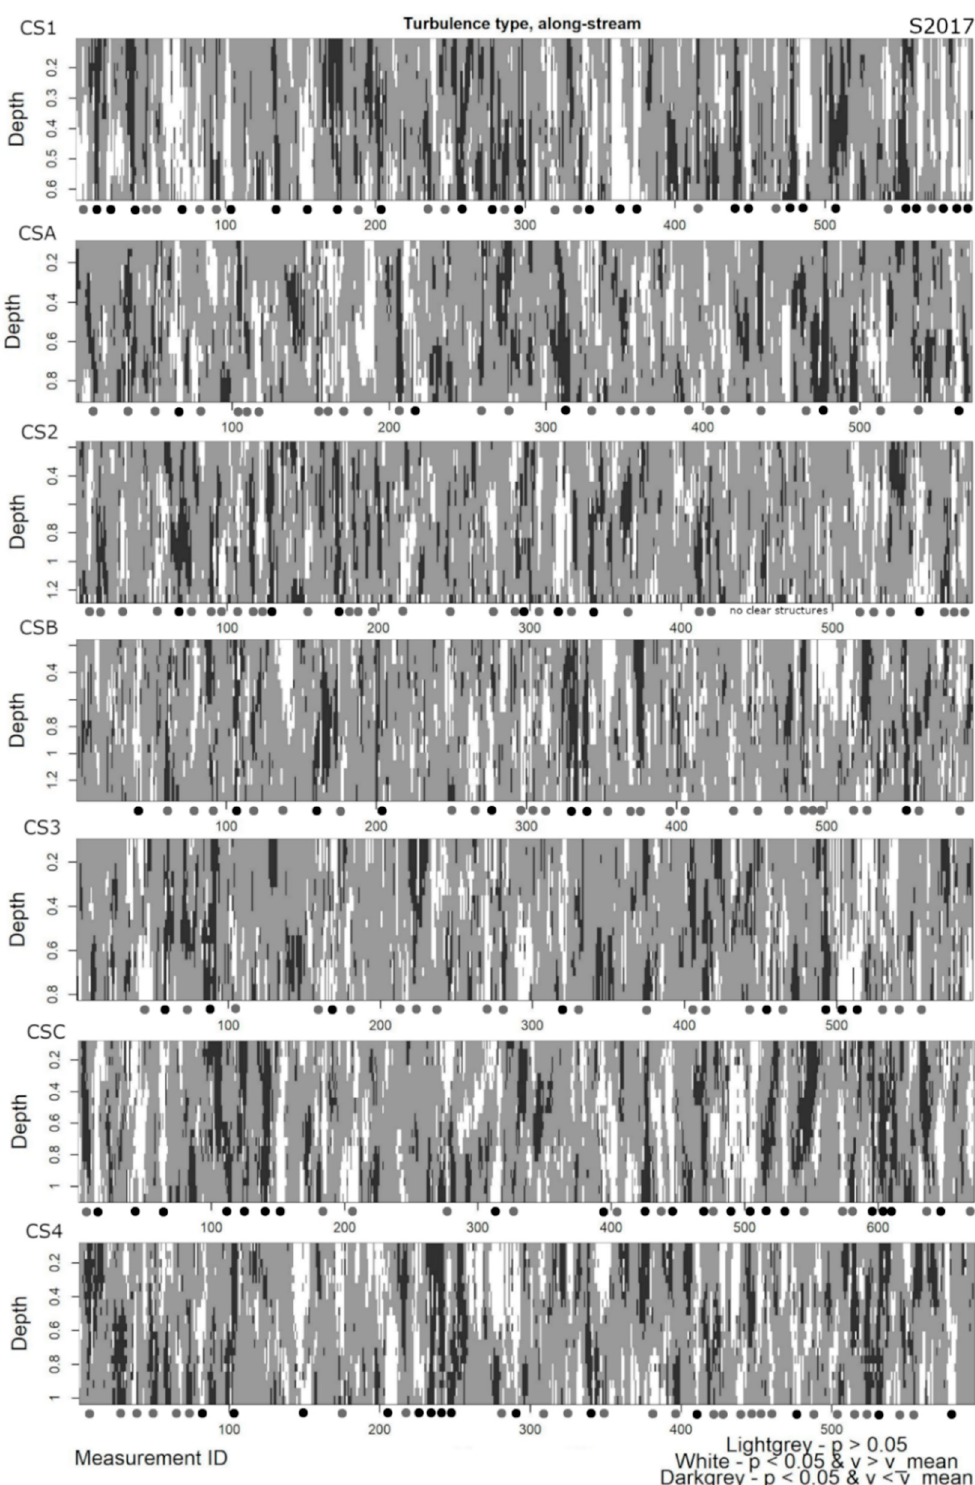
Figure 4. The LISA analysis results at each measurement location, calculated based on along-stream (i.e., streamwise) velocity of S2017. Measurement ID means the sample numbers ( n ), and therefore also represents seconds. The black dots indicate the occurrence times of statistically significant strong high and low flow wedges reaching from the surface to the riverbed. The grey dots indicate the times when there is weaker wedge (i.e., a cluster has broken with a few cells within the vertical water column).